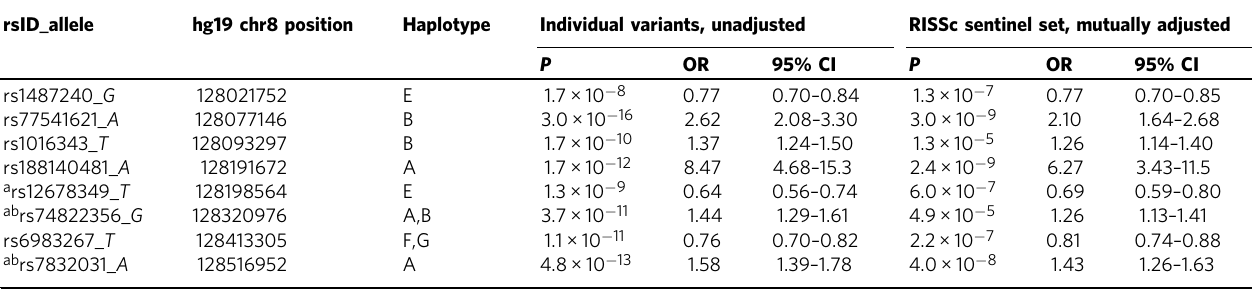
Table 3 Sentinel variants associated with HPC among combined